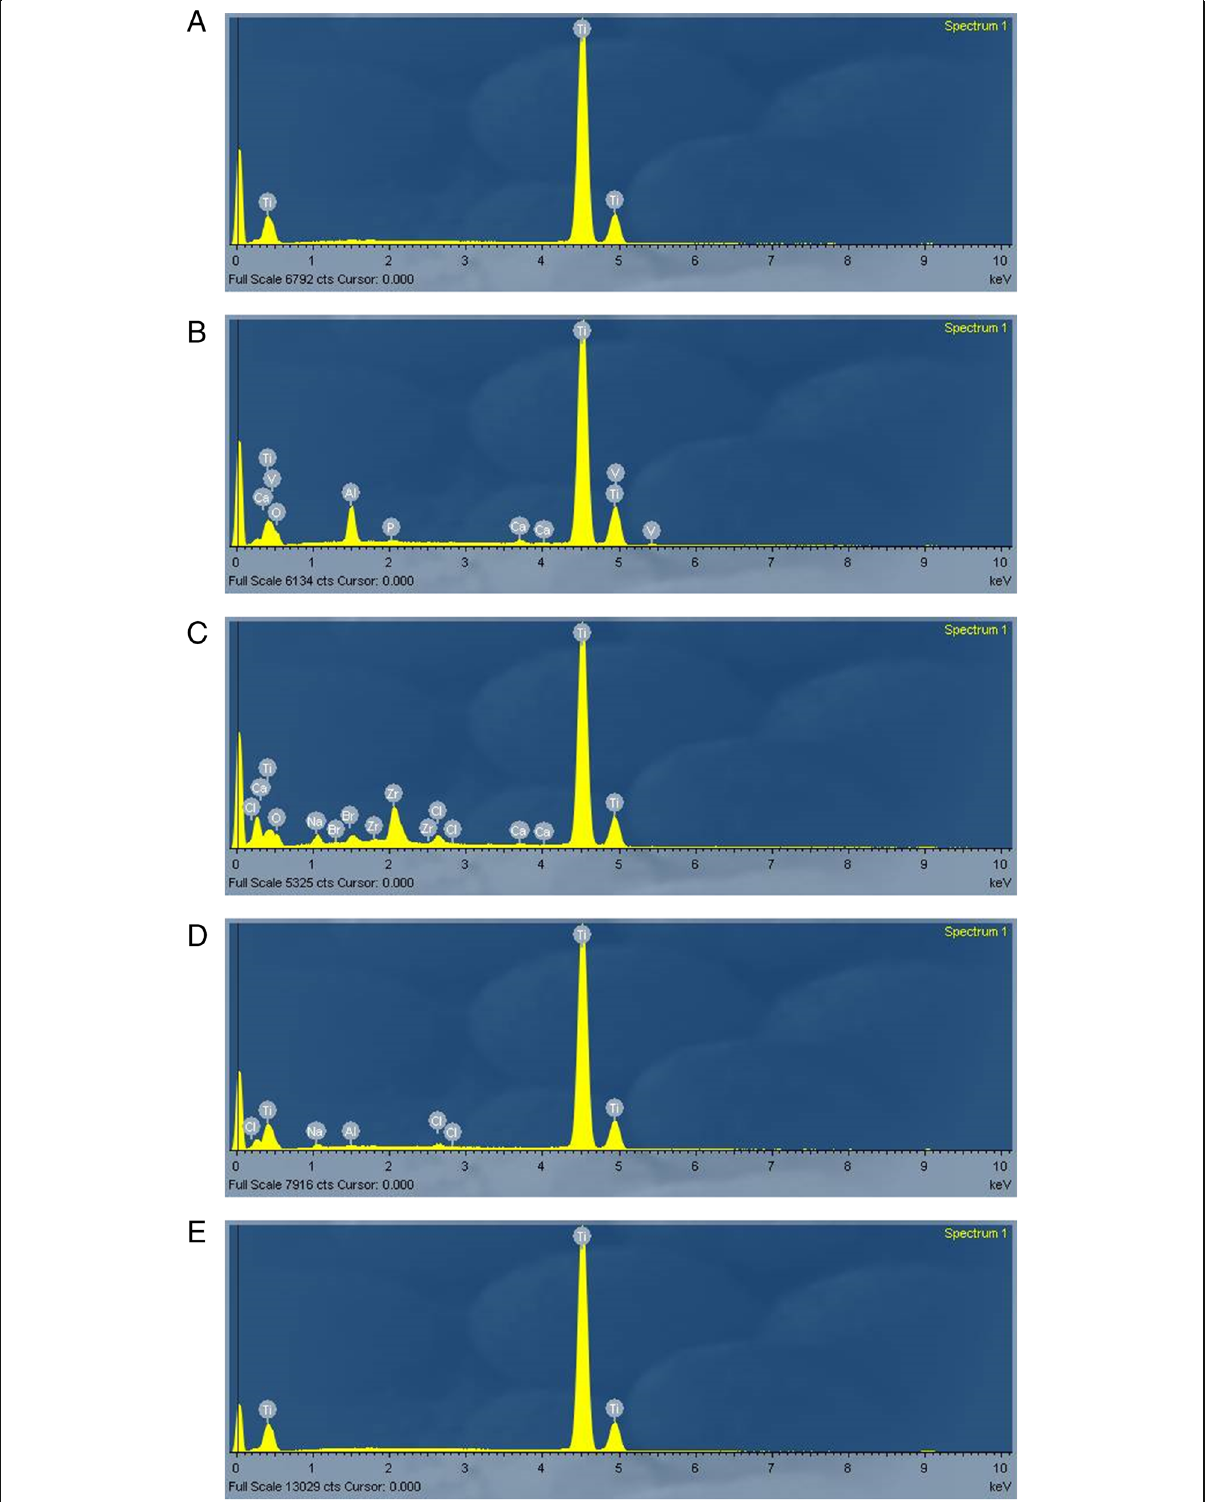
Fig. 4 Spectrum of EDS for the area analyzed. Chemical composition of titanium with different surface treatment, note the high peaks of titanium element ( a , b , c , d , and e ). a Nanotite. b Osseotite. c SLActive. d Acqua. e Cone